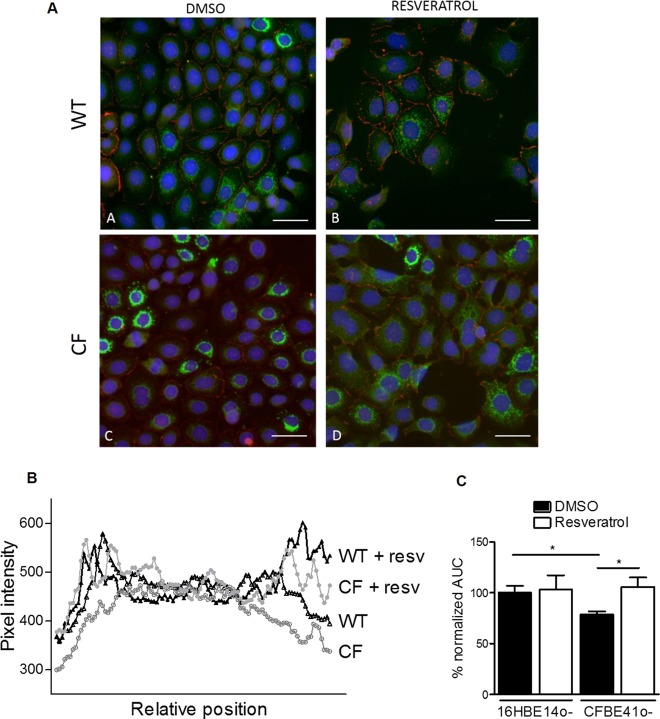
Quantification of CFTR protein by immunofluorescence in human bronchial epithelial cells. (A) Representative immunohistochemical labeling of CFTR (green) and zonula occludens (ZO-1, red) 24 h after incubation with DMSO (left) or 100 µM resveratrol (right) in wild-type 16HBE14o− (WT, top) or in CFBE41o− (CF, bottom) cultures. Nuclei (blue) stained by DAPI. Bar: 20 µm. (B) Relative position corresponding to intensity of the CFTR signal quantified by morphometric analysis of cross-sectional profiles in individual (n=8 cells per condition, randomly selected). (C) Average area under the fluorescence curves (±s.e.m.) obtained in B normalized to that measured in DMSO-treated wild-type cells and expressed as a measure of total CFTR protein expression (*P<0.05, Student t-test). Data from a representative experiment selected from a series of 3 experiments with similar results. Resv, Resveratrol.